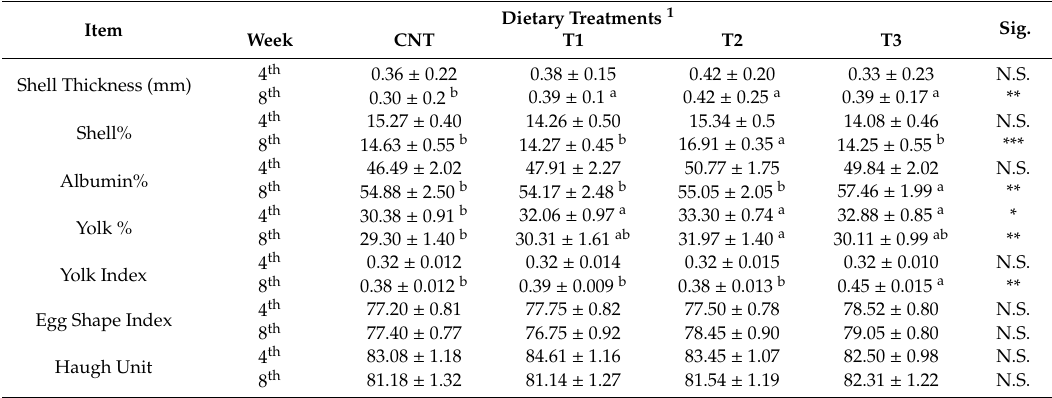
Table 5. E ff ect of the Moringa oleifera supplementation on egg quality traits, in the 4th and 8th week of the experimental